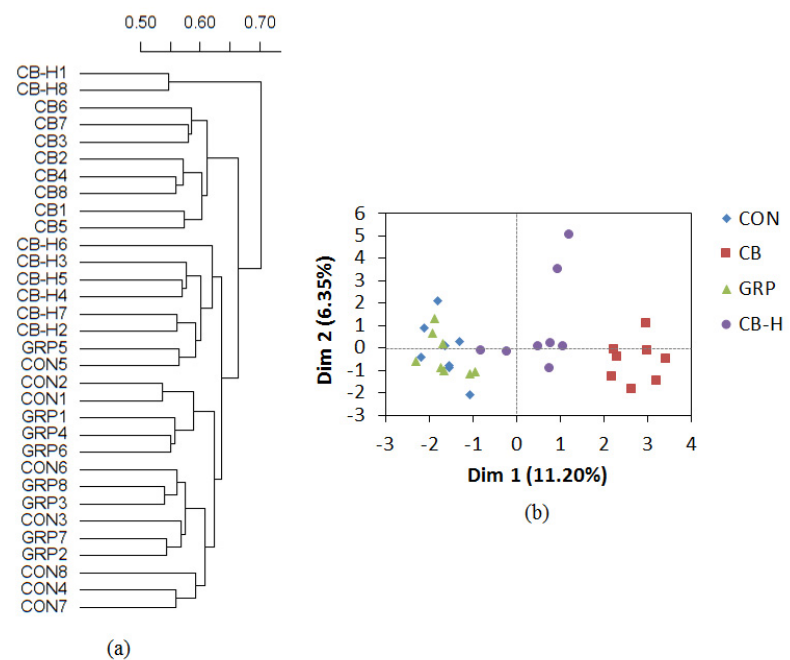
Figure 4. Impact of GRP and other broccoli components on rat cecal microbial communities. Rats were fed with a 10% cooked broccoli (CB), GRP-rich powder (GRP), broccoli pre-hydrolyzed using myrosinase (CB-H) or the control diet (CON) for four days ( n = 8). ( a ) Phylogenic tree describing the clustering of cecal microbial communities; and ( b ) PCA-individual factor map describing the cecal microbial communities.